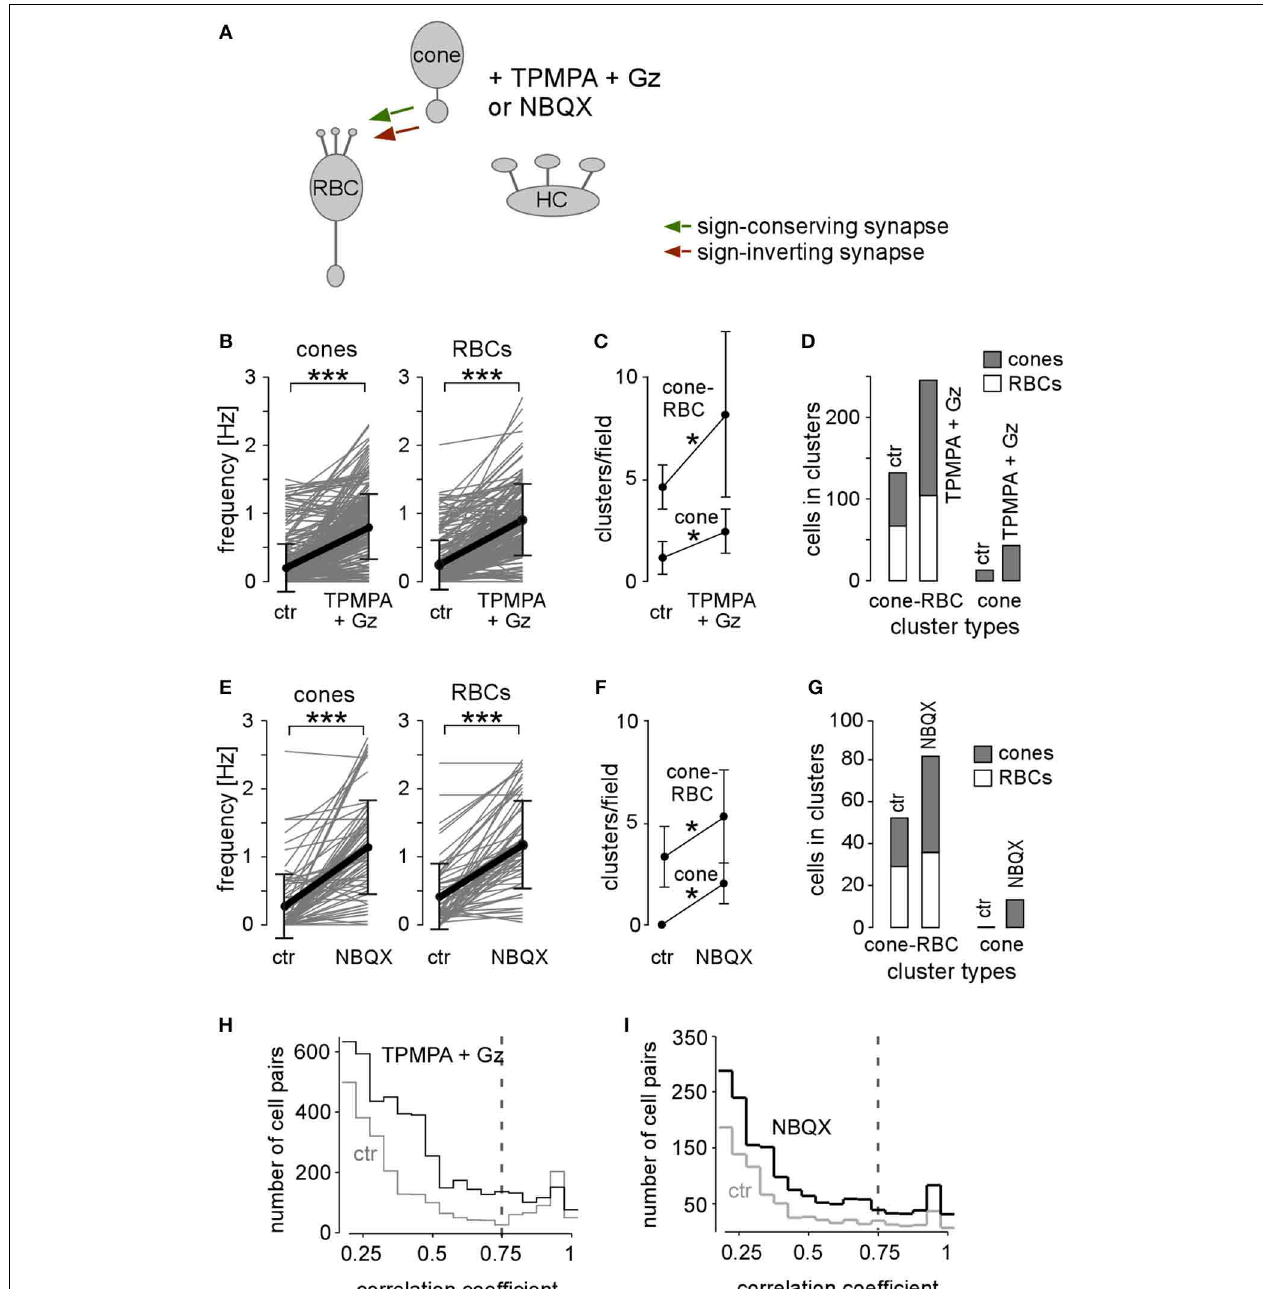
FIGURE 6 | Blocking HCs increases synchronous activity in cones and rod bipolar cells. (A) Drawing shows synaptic interactions of outer retinal neurons with GABA receptor antagonists (TPMPA + Gz) or AMPA/kainate-type GluR antagonist (NBQX). (B–D) Effect of TPMPA + Gz on F mean ( B ), cluster number ( C ) and cluster composition ( D ). (E–G)